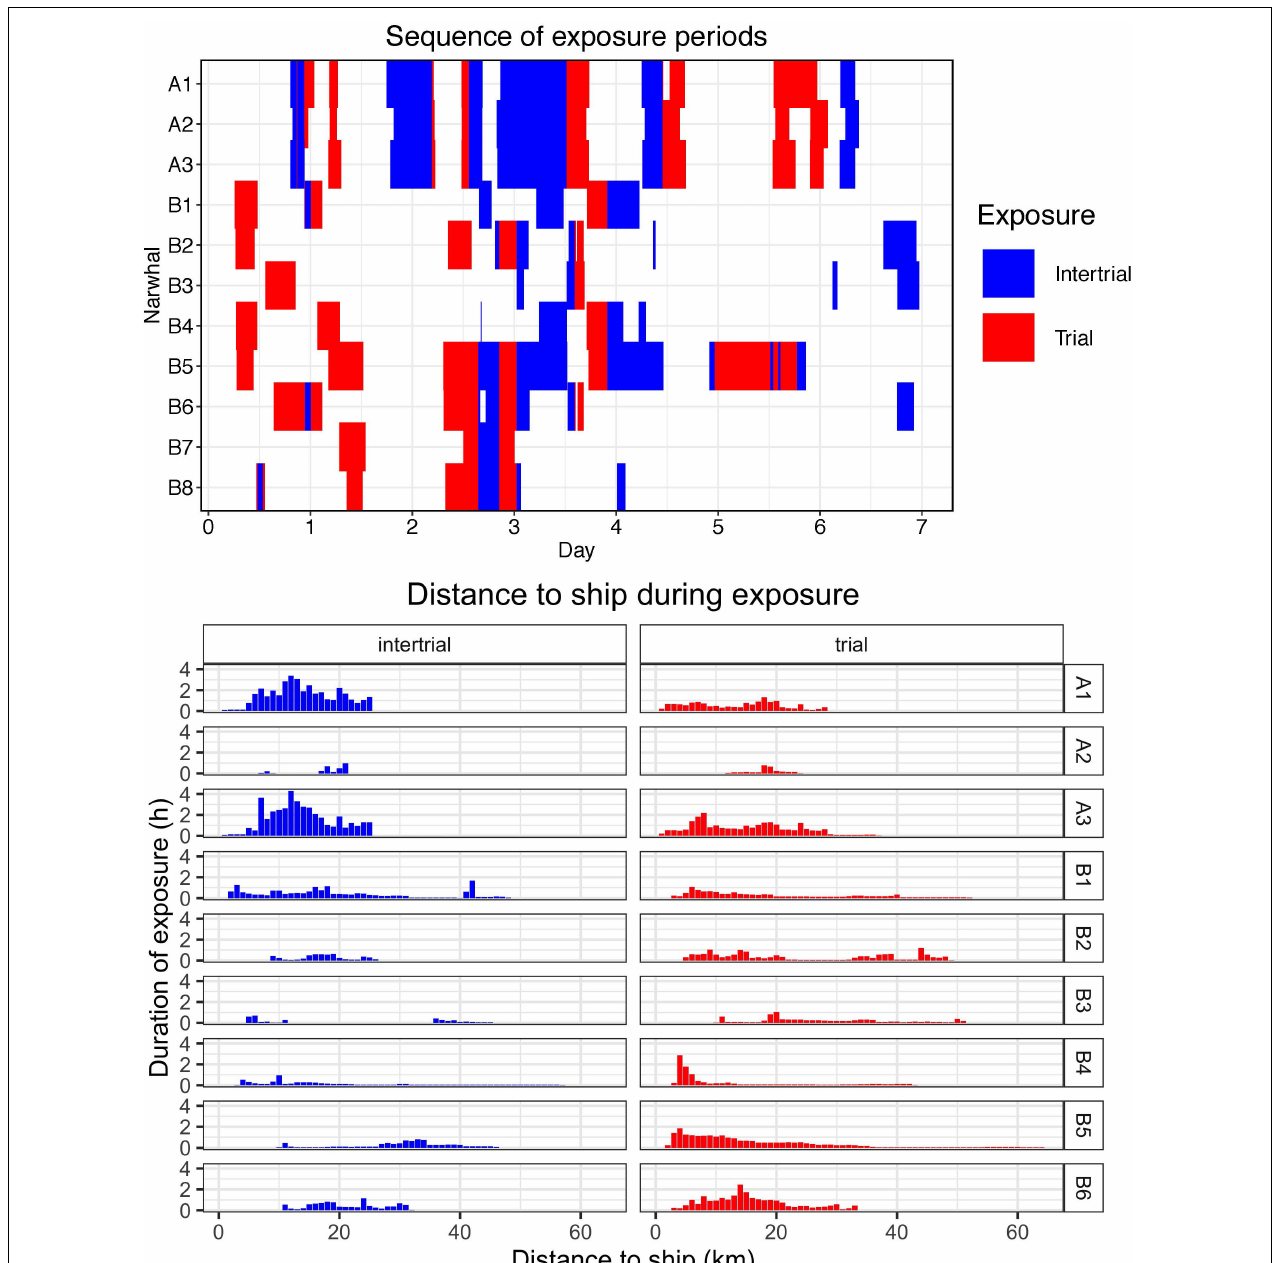
FIGURE 2 | Upper panel The sequence of periods where each whale was exposed to the presence of the ship (intertrial) and seismic activity (trial) for the 11 whales with Fastloc or Fastloc CTD transmitters. Lower panel Duration (in hours) of exposure to the presence of the ship and seismic activity for the nine deployments with Acousonde recorders. Duration of exposure was calculated for 1-km